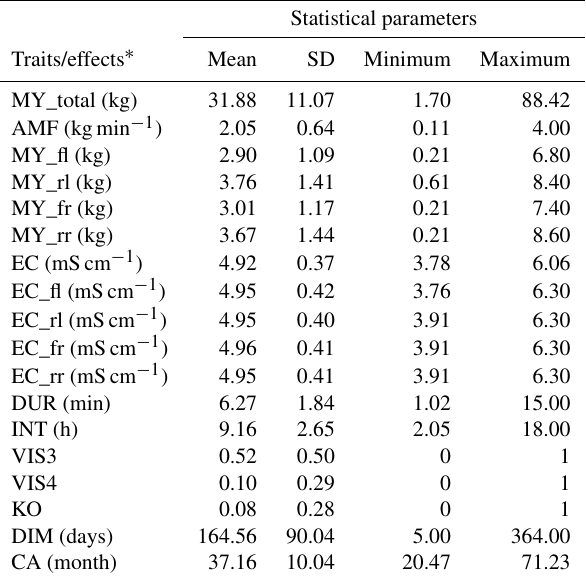
Table 3. Descriptive statistics for all traits and effects. Statistical parameters